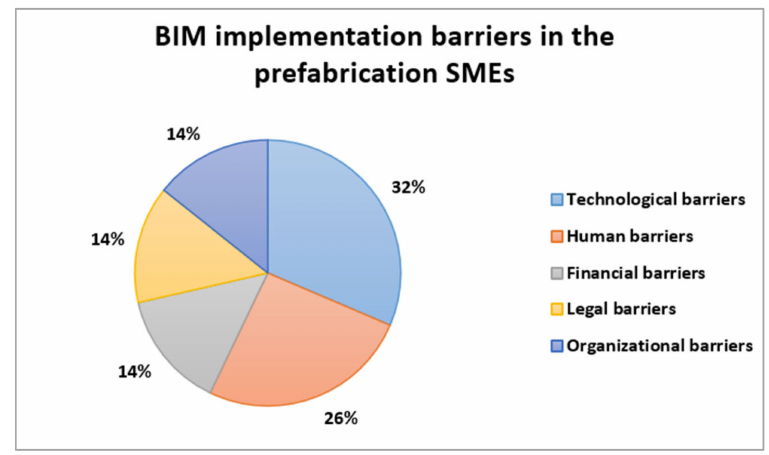
Figure A4. Barriers to BIM implementation according to prefabrication